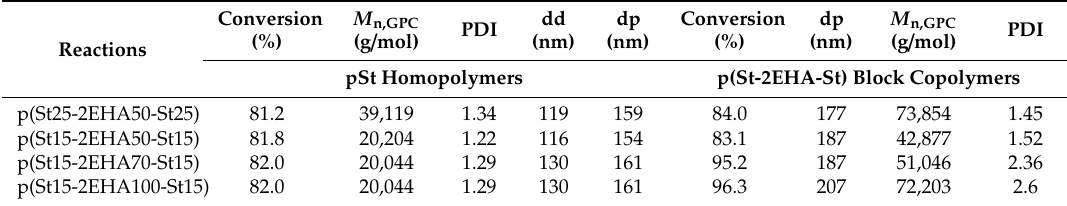
Table 1. Conversion, average droplet (dd) and particle size (dp), M n and PDI at the end of reaction for pSt homopolymers and p(St-2EHA-St) block